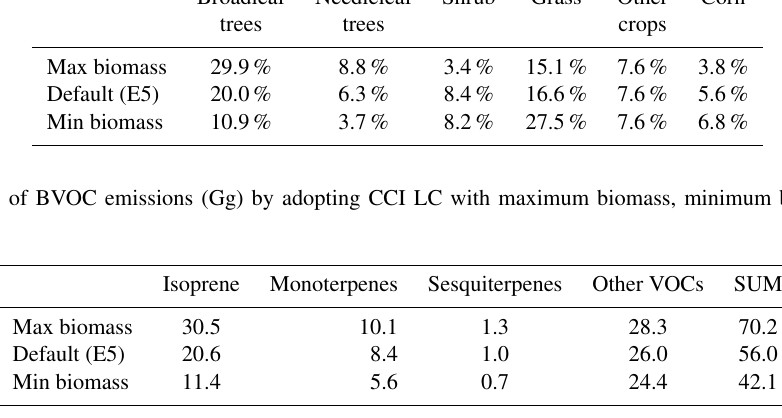
Table 8. Comparison of the average emission intensities of isoprene and monoterpenes from this study and previous